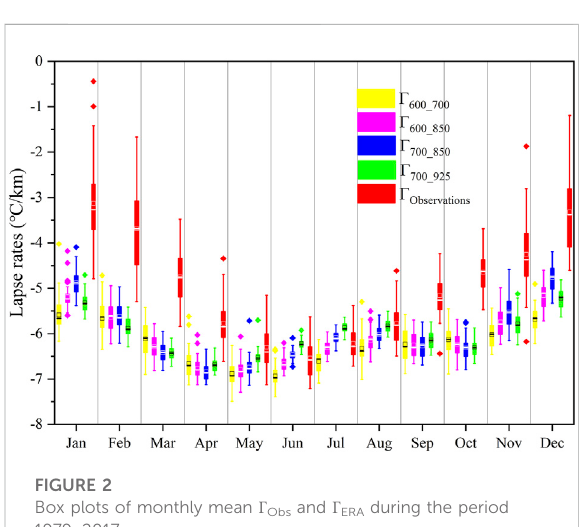
FIGURE 2 Box plots of monthly mean Γ Obs and Γ ERA during the period 1979 ‒ 2017.